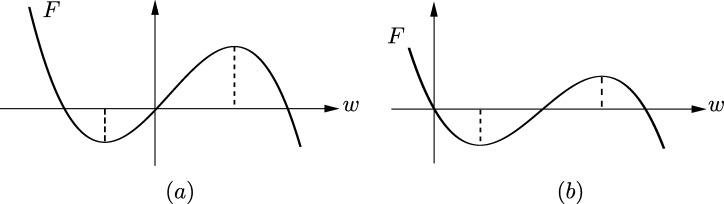
Sketch of the graph of F: (a) when α > 0, (b) when α < 0 and β > 0.